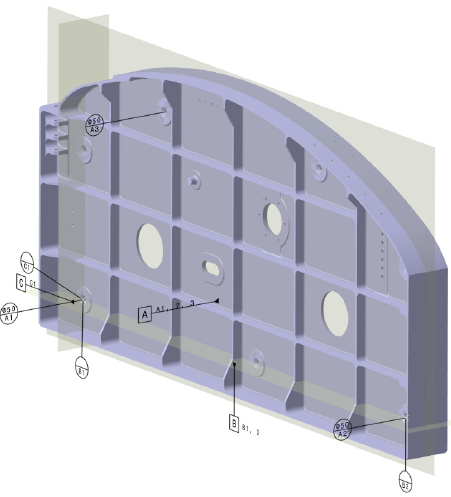
Figure 15. Main datum reference system in ISO model.